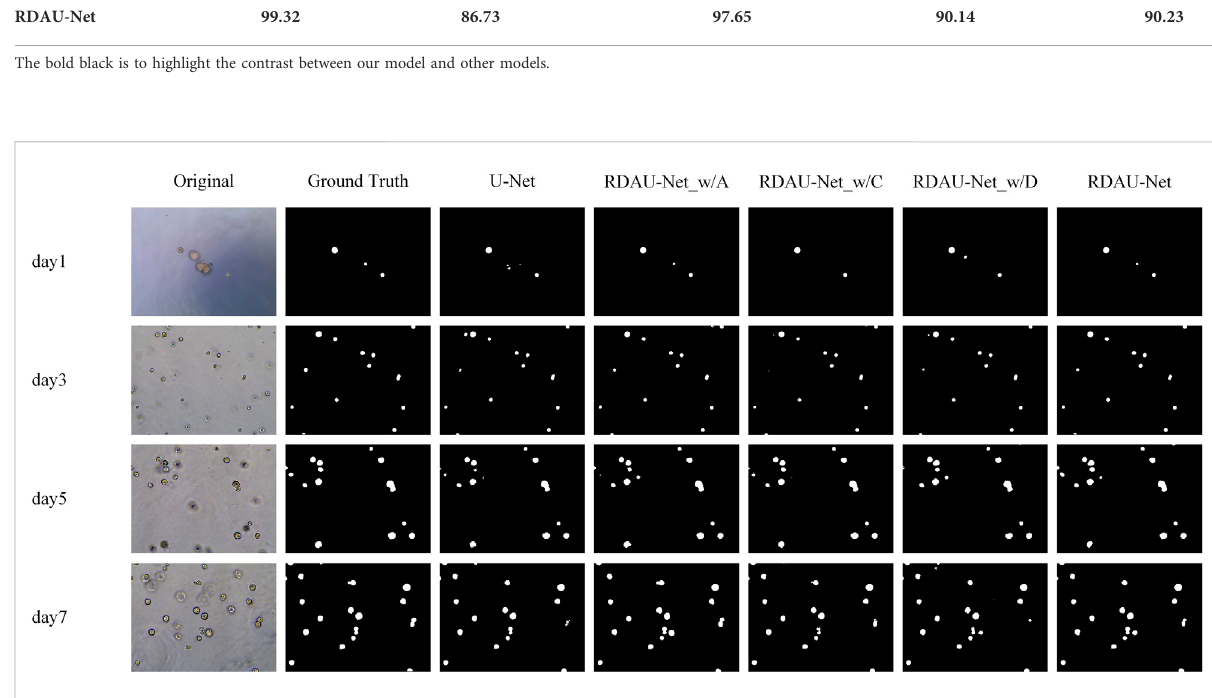
FIGURE 10 Segmentation results of different models for 1-, 3-, 5-, and 7-day images of